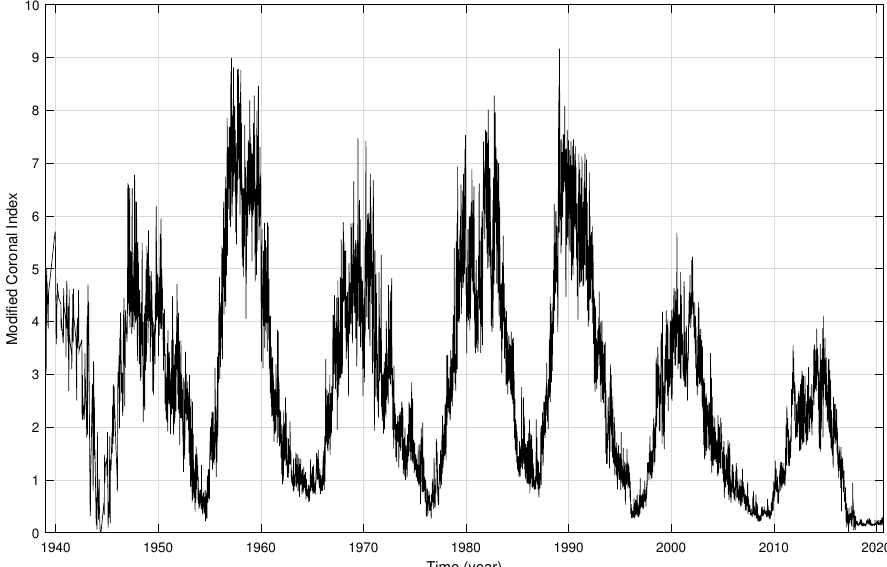
Figure 1. Daily time series of modified coronal index for 1 January 1939–31 August